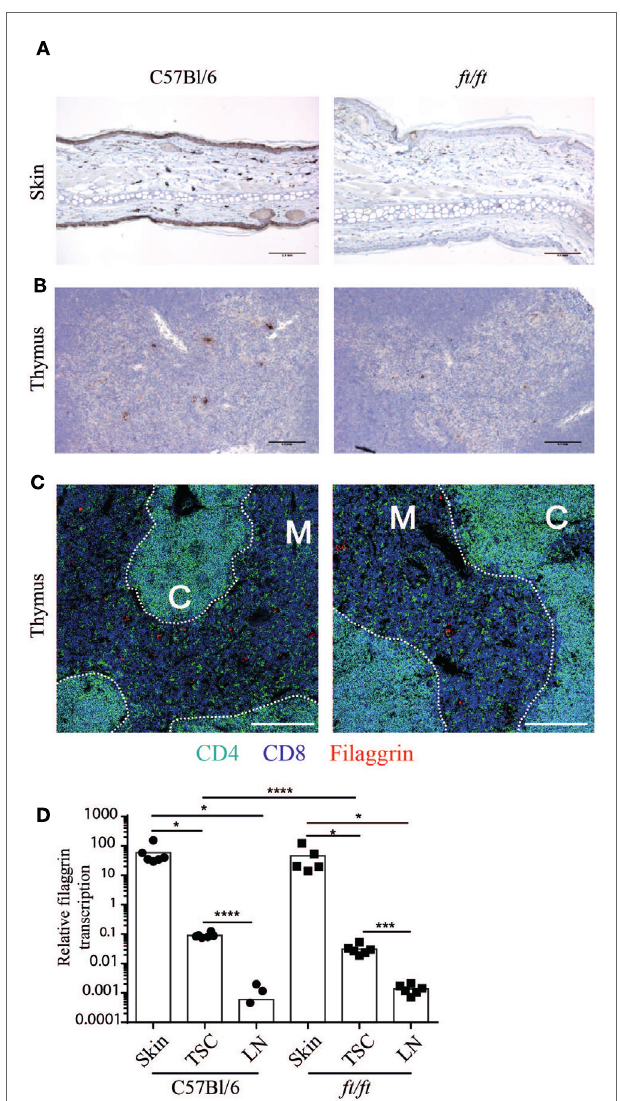
FigUre 3 | Decreased filaggrin expression at the transcriptional level in the thymus of ft/ft mice. (a–c) Immunohistological analyses of ears and thymi from 8 to 12 weeks old C57Bl/6 and ft/ft mice. Sections of (a) ears and (B) thymi were stained with anti-filaggrin antibody. The sections are magnified × 200 and the bars indicate 0.1 mm. (c) Confocal microscopy images of thymi showing expression of CD4 (green), CD8 (blue), and filaggrin (red). The bars indicate 200 µm. (D) Relative profilaggrin transcription in the skin, thymic stromal cells (TSC), and lymph nodes of ft/ft and C57Bl/6 mice. The Ct-values of profilaggrin transcription were normalized to the transcription of GAPDH. The means ( n = 6) are indicated by bars. For C57Bl/6 lymph nodes, three values of profilaggrin transcription were zero and are therefore not indicated with dots on the logarithmic scale. Expression of profilaggrin of TSC was compared to skin and lymph nodes for each